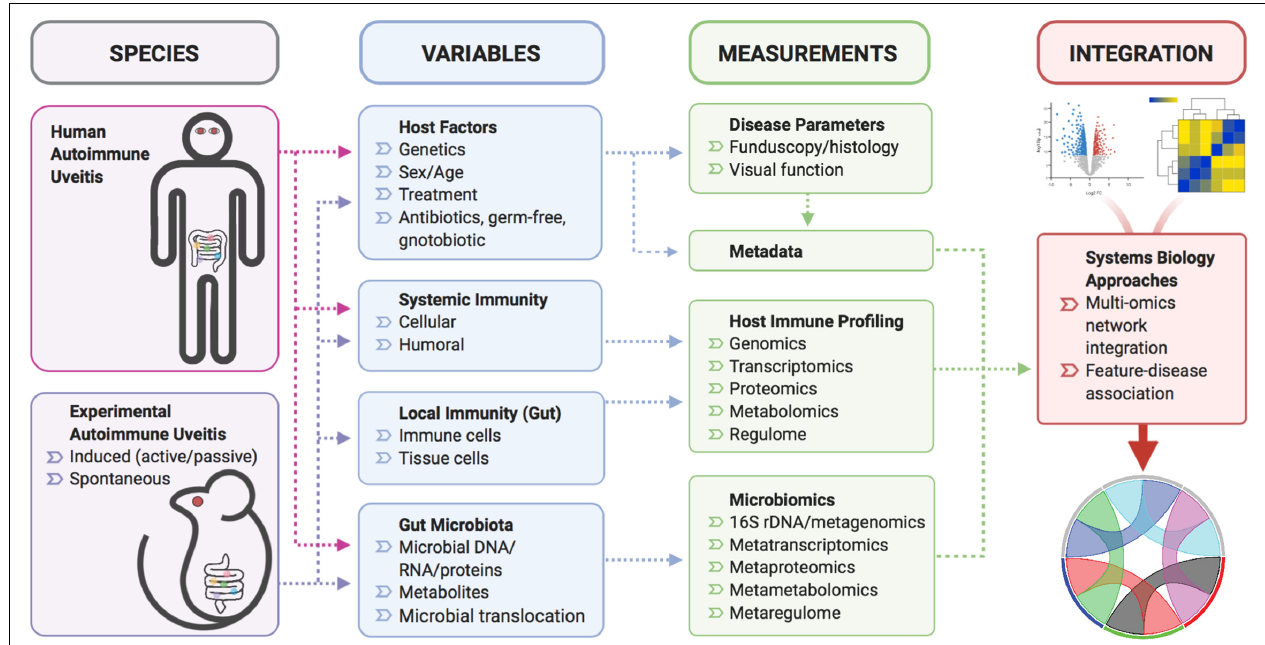
FIGURE 2 | A schematic of multi-omic, systems biology approach for uveitis studies. Various mouse models of autoimmune uveitis or human uveitis patients will be sourced for blood and fecal samples. At the time of biological sample collection, variables that influence systemic/local immunity and the gut microbiota can be analyzed to yield data in the form of disease severity respective to host immune and microbiome status. These data could then be subjected to integrative multi-omic network analyses to provide meaningful relationships among various data types.